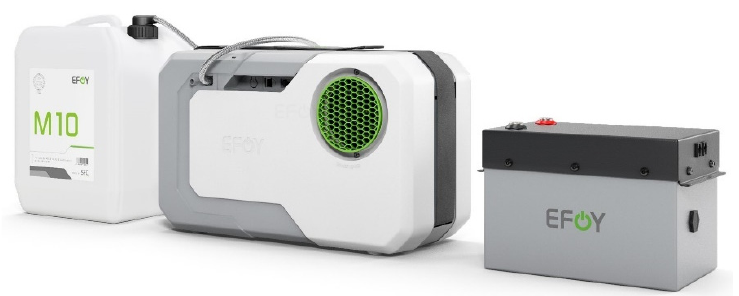
Figure 1. Commercial direct methanol fuel cell system . Photo credit: SFC Energy AG.